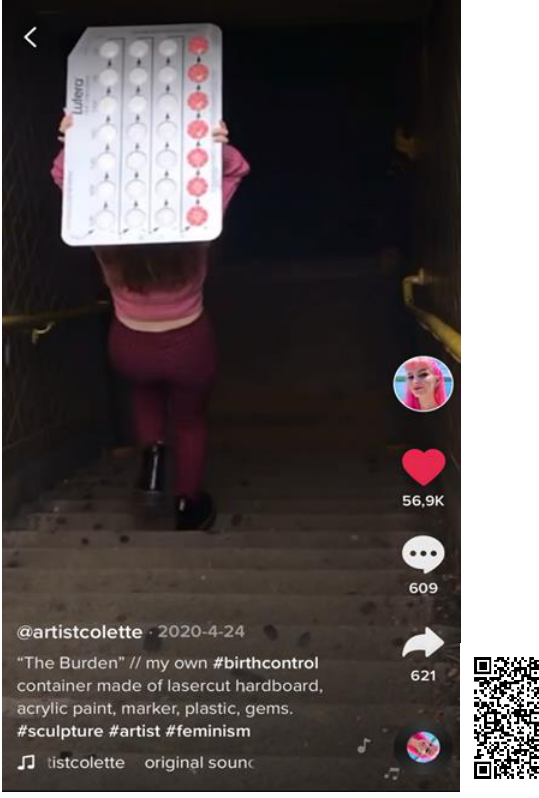
Figure 3. Performance of Colette Bernard “The Burden”.